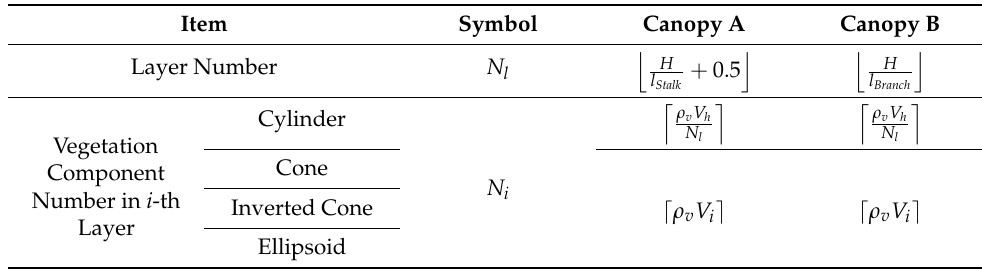
Table 3. The number of layers in the four canopies with different crown shapes and the number of vegetation components in each layer.